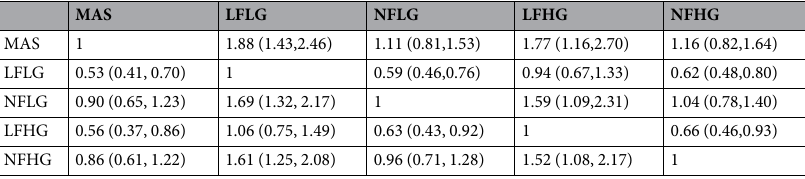
Table 4. Rate ratios of all-cause mortality from network meta-analysis with 95% confidence interval. MAS: moderate aortic stenosis; LFLG: low-flow low-gradient; NFLG: normal-flow low-gradient; LFHG: low-flow high-gradient; NFHG: normal-flow high-gradient. All the RRs were presented using the row sub-type as the reference